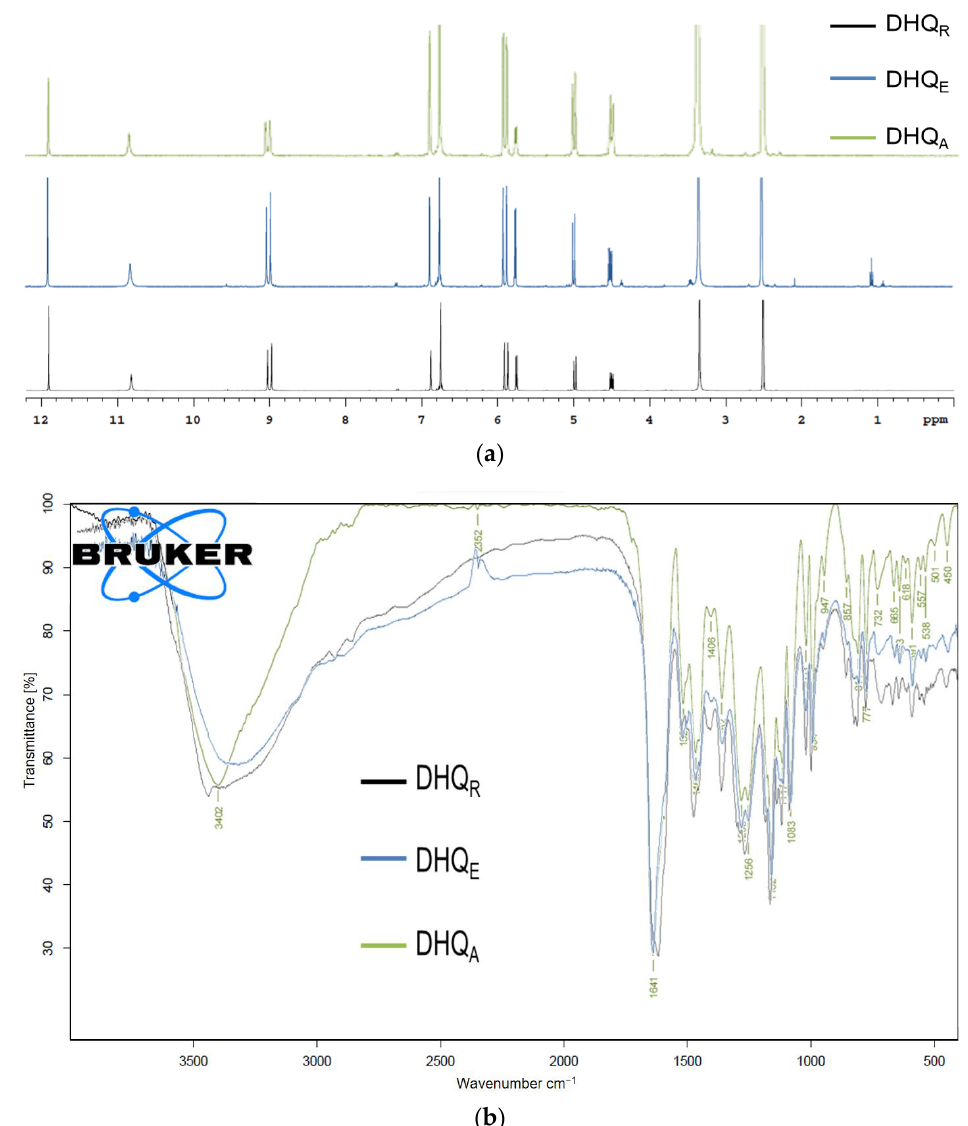
Figure 4. Spectral analysis of DHQ forms: ( a ) NMR 1 H spectroscopy; ( b ) IR spectroscopy. The lyophilized samples were obtained from ethanol and acetonitrile solutions with 5% concertation of organic solvent.